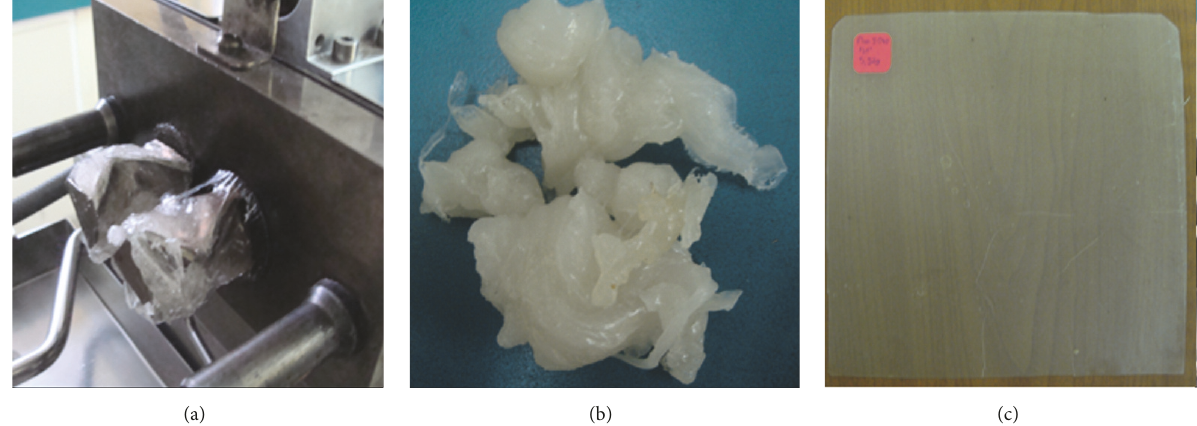
Figure 1: Process to obtain the prodegradant additive/LDPE films. (a) Internal torque mixer, (b) homogeneous mass of mix, and (c) final film